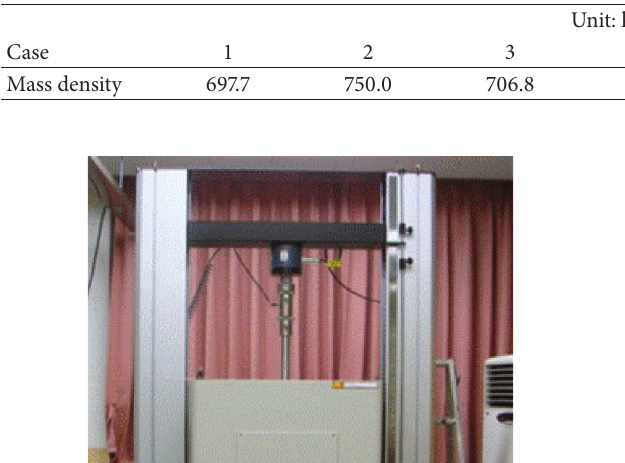
Figure 5: Load-displacement curve of NGH pellet (PR 1: 3, FP 5 kgf, RPM 1).